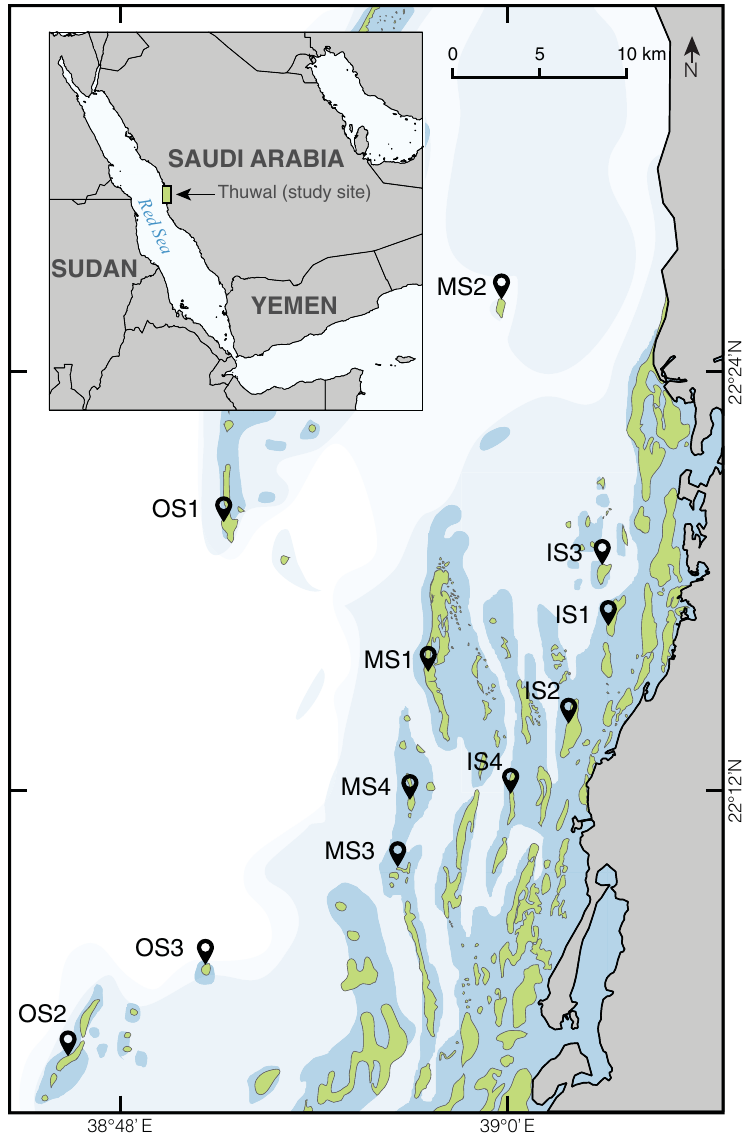
Fig 1. Map of the 11 reefs surveyed off the coast of Thuwal, Saudi Arabia in the central Red Sea in September 2015. Abbreviations are as follows: OS (offshore), MS (midshelf), and IS (inshore). Modified and reprinted from [26] under a CC BY license, with permission from Springer Nature, Coral Reefs (2017)(S2 File).